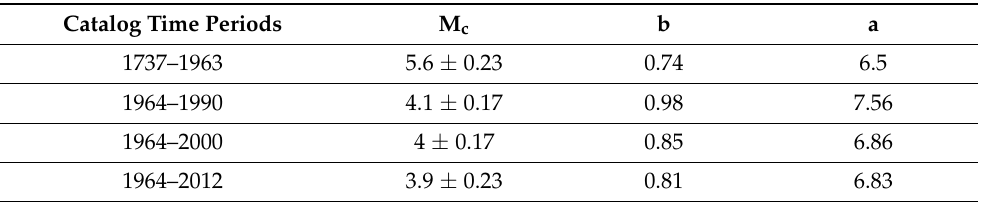
Table 4. Estimated Mc, ‘b,’ and ‘a’ values for various